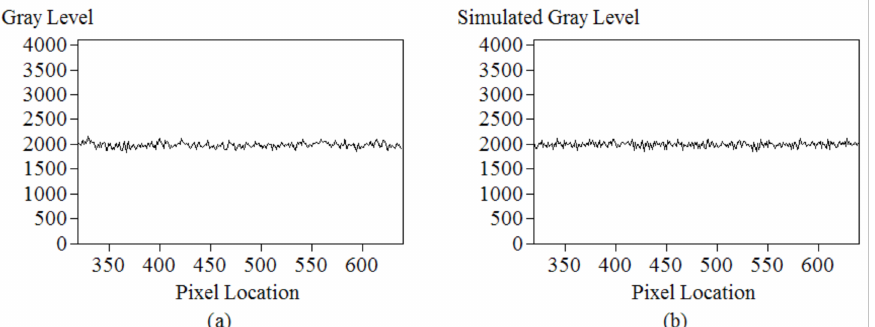
Figure 13. ( a ) The 1D distribution of I d when illuminating a screen with an input gray level I p = 120. ( b ) Simulated 1D distribution.